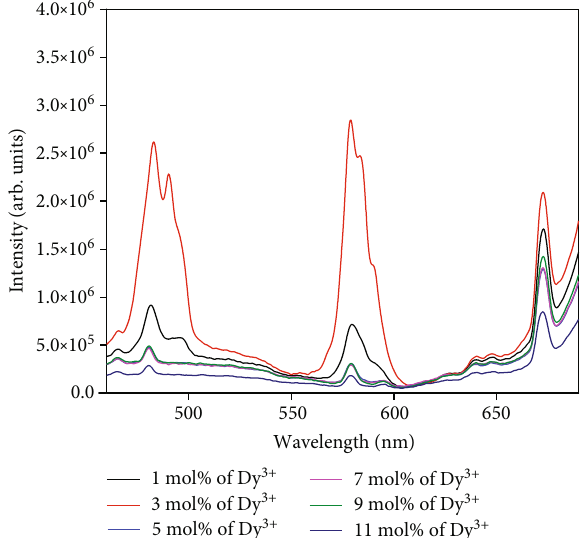
:Dy 3+ (1 – 11 mol%) NMs 2